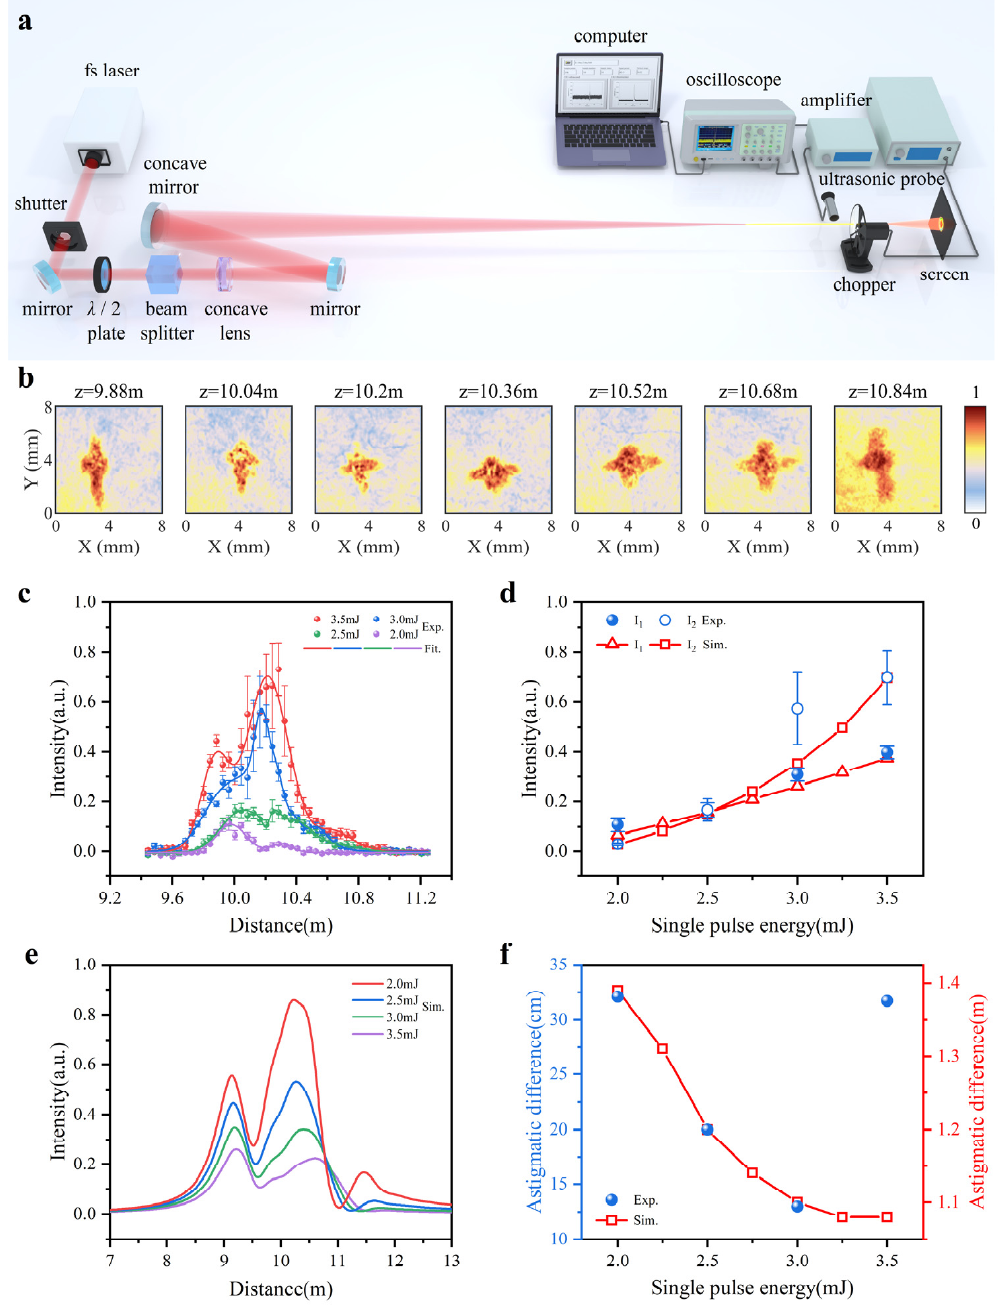
Figure 4. Experimental setup and results: ( a ) Experimental setup; ( b ) Thermal paper recorded laser beam intensity distribution at different distances with a pulse energy of 3.5 mJ; ( c ) Evolution of the ultrasonic intensity as a function of propagation distance at different single pulse energies; ( d ) Var- iation of the maximum ultrasonic intensities 𝐼 (cid:2869) and 𝐼 (cid:2870) versus single pulse energies compared to simulation results; ( e ) Simulation results of on-axis intensity as a function of propagation distance at different single pulse energies; ( f ) Astigmatic difference expressed as the distance between 𝐼 (cid:2869) and 𝐼 (cid:2870) at different single pulse energies compared to simulation results.